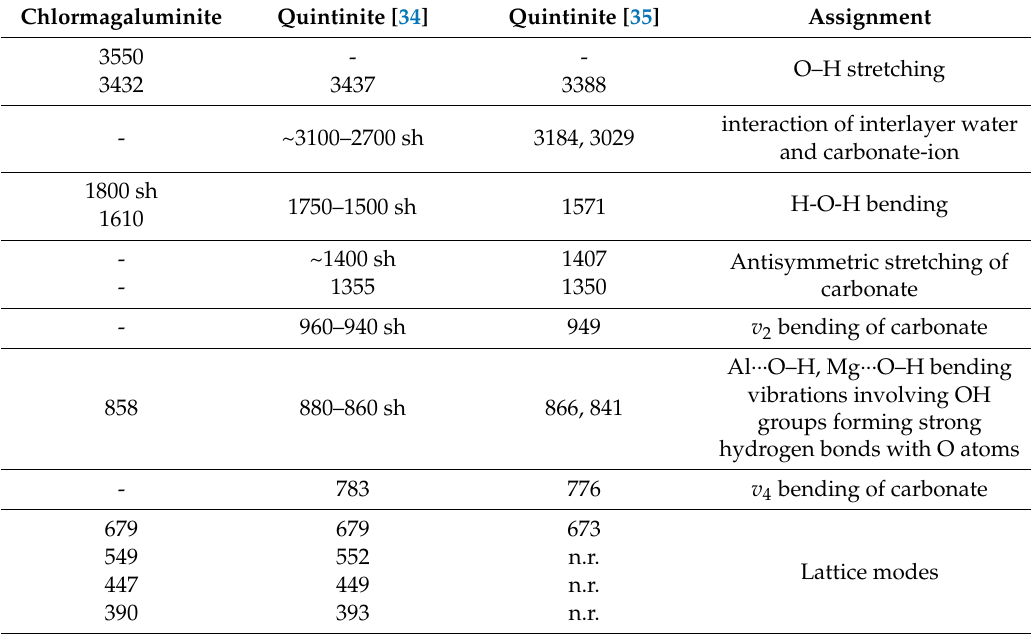
Table3. Assignmentofinfrared(IR)bands(cm − 1 )ofchlormagaluminiteanditscomparisontoquintinite.